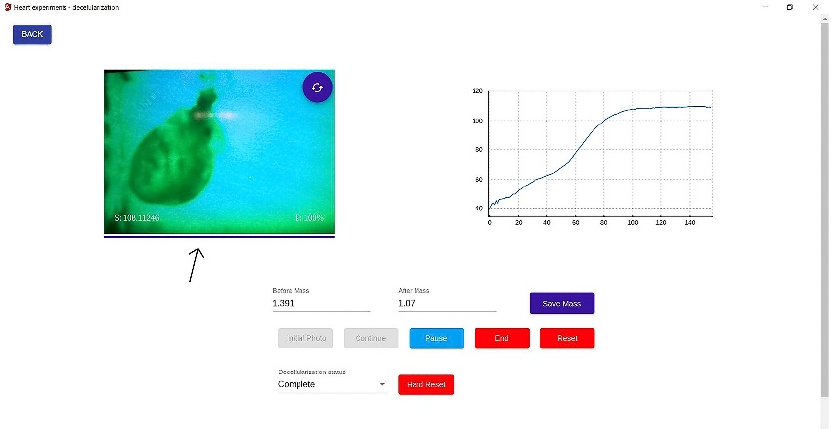
Figure 9. The graphical user interface of a whole decellularized heart. The process is complete when the classification metric represented by the progress bar below the camera is 100%, and the spectrometer metric reaches a plateau. The spectrometer’s graphic shows the number of cycles on the horizontal axis and the mean of the heart pixels per cycle on the vertical axis. As stated above, every cycle has 400 photos. The hearts are being weighed before and after each session, losing 0.32 ± 0.08 g post-decellularization.